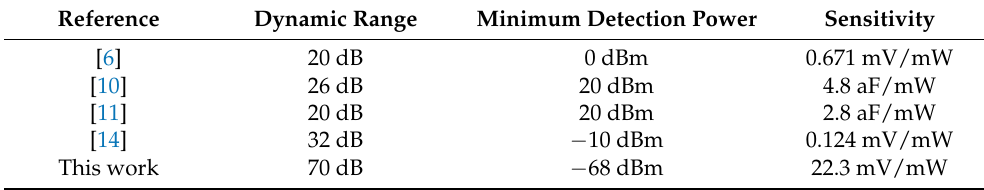
Table 3. Comparison of dynamic range, minimum detection power and sensitivity.